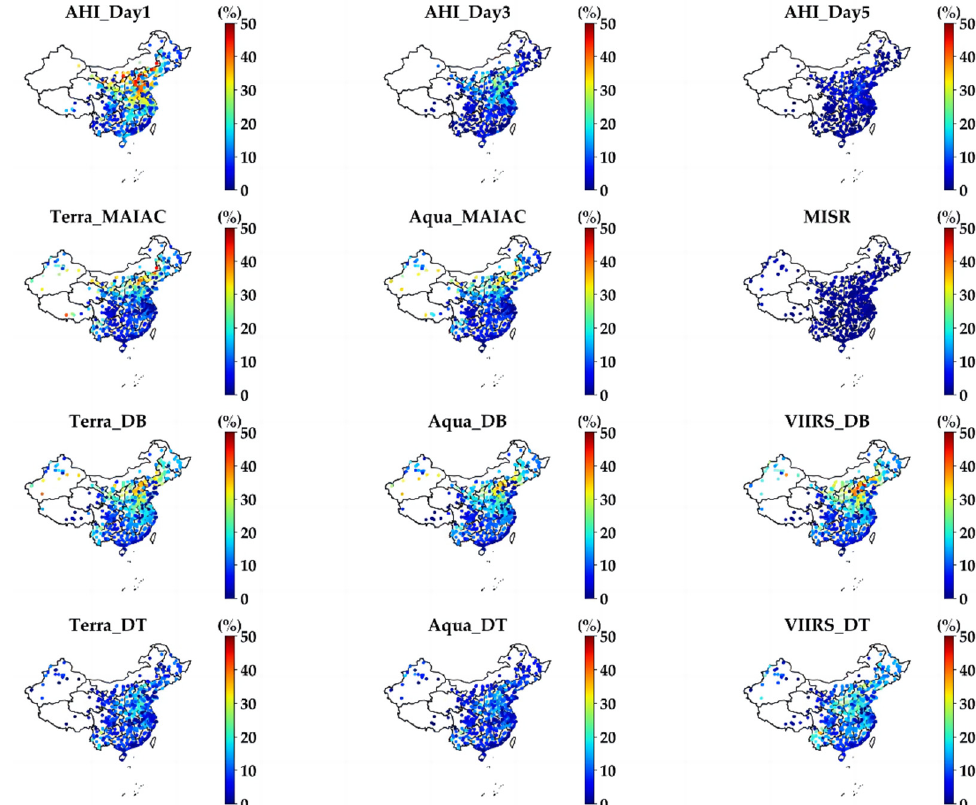
Figure 9. The percentage availability of the LEO-GEO satellite AODs with valid matches to the PM 2.5 concentration in each monitoring site for 2016–2018. AHI_Day1 represents at least one AHI AOD match to PM 2.5 per station per day, AHI_Day3 denotes at least 3 matches per station per day, and AHI_Day5 stands for at least 5 AODs per station per day. The remaining are the LEO satellite AODs.